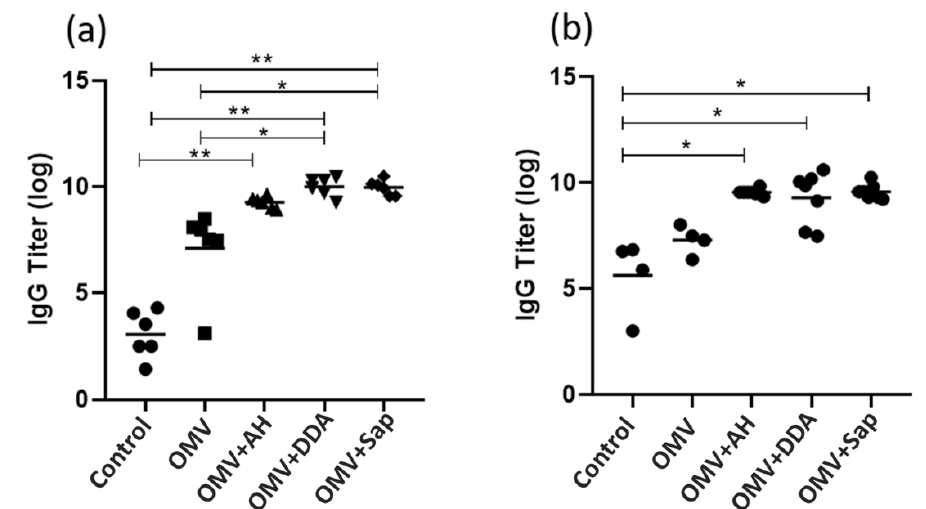
Figure 4. Antibody titer analysis of ( a ) Total IgG 30 days after the subcutaneous booster (OMV, OMV+AH and OMV+DDA) or 15 days after the 2nd booster (OMV+Sap); ( b ) persistence of total IgG, when mice were 18 months old. * p < 0.05; ** p < 0.01; AH: aluminium hydroxide; DDA: dimethyldioctadecylammonium bromide; OMV: outer membrane vesicles; Sap: